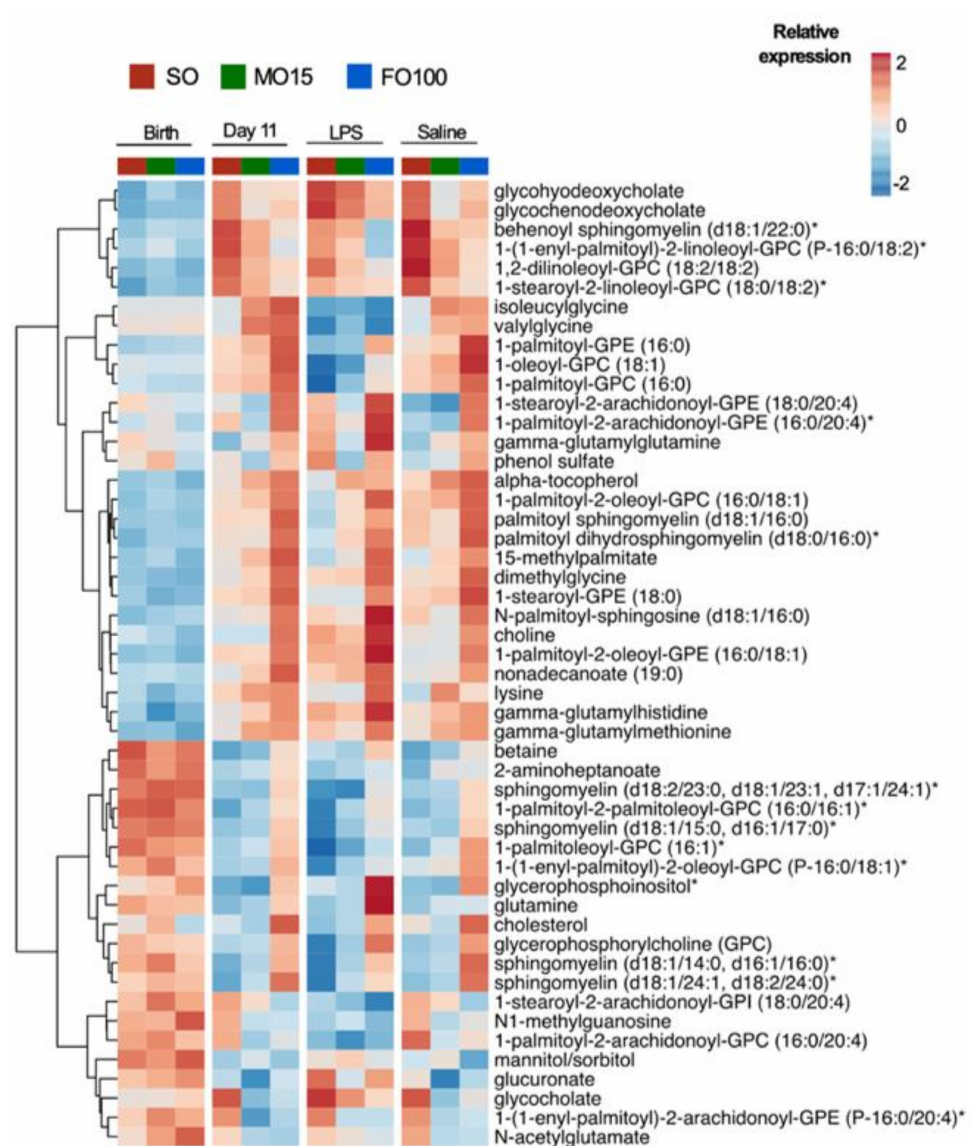
Figure 9. Changes in plasma lipid metabolites at birth, day 11, and at the end of an 8 h continuous infusion of saline or LPS on day 11 by lipid group, SO ( n = 16), MO15 ( n = 13), and FO100 ( n = 19). The heatmap shows the median relative expression of the top 50 significantly different lipid metabolites by 2-way ANOVA (lipid × day) per lipid groups. FO100, 100 percent fish oil; LPS, lipopolysaccharide; MO15, mixed oil with 15% fish oil; SO, 100% soybean